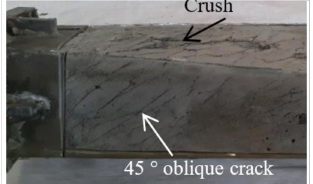
Figure 5. Failure model of concrete.